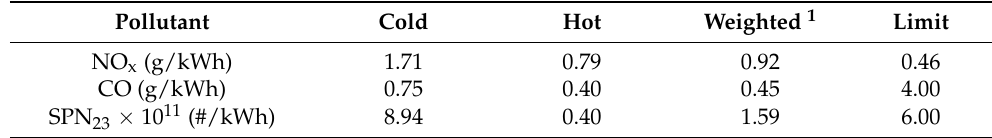
Table 2. Emission factors of type-approval-like WHVC of the vehicle of our study and the respective limits in the regulation for WHTC and engine dynamometer testing. Cold Hot Weighted 1